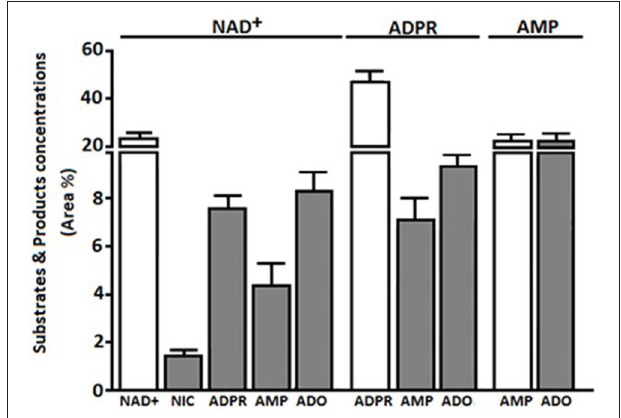
FIGURE 3 | Extracellular products of CIK enzymatic reactions using NAD + , ADPR, and AMP as substrates. Products (NIC, ADPR, AMP, or ADO) obtained from bulk CIK cell cultures ( n = 5) using (i) NAD + , (ii) ADPR or (iii) AMP as substrates, were evaluated by HPLC assays in the presence of the adenosine deaminase inhibitor (EHNA) as described in Materials and Methods. Products (gray bars) are expressed as area percentage (Area %) for each enzymatic product as compared to the total components present in the ACN-treated CIK cell supernatant (100%). Substrates are represented as Area % of consumed substrate (white bars). Results indicate that bulk CIK cells efficiently hydrolyze NAD + , ADPR and AMP to generate ADO. Of note, CIK cells produce low or undetectable amounts of ADO when incubated with NAD + , ADPR, or AMP substrates in the absence of EHNA (not shown). The identity of peaks was confirmed by the co-migration of reference